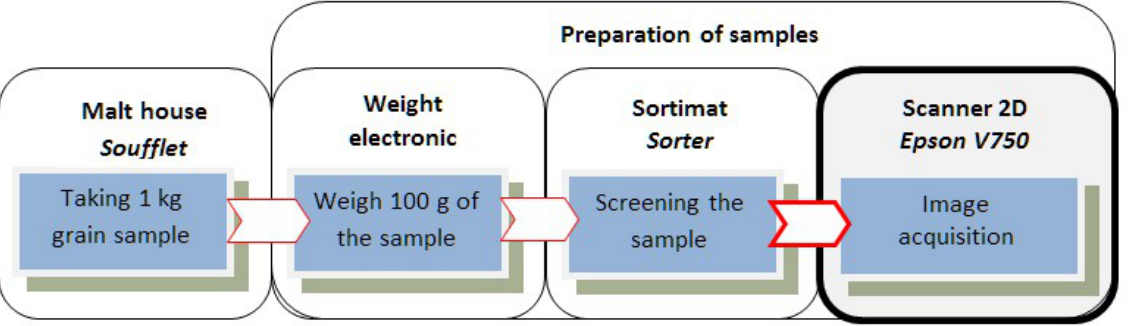
Figure 1. Scheme of sample preparation for barley kernel image acquisition. To obtain digital images representing seeds of the Sebastian variety, an EPSON V750-M Pro 2D flatbed scanner was used, which allowed for obtaining high-quality sets of photos. The applied parameters of the scanner were as follows: optical resolution—6400 dpi, optical density—4 Dmax, color depth—input/output 48 Bit Color, converter—CCD, and light source—cold cathode fluorescent lamp [17] (see Figure 2).